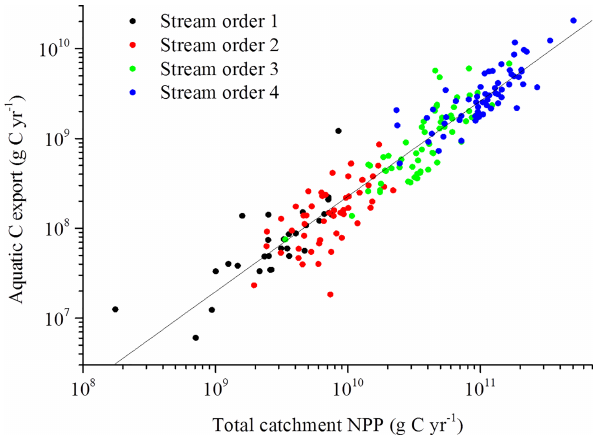
Figure 3. Annual rate of C export through the stream network ver- sus terrestrial NPP in the catchment area. Different colors indicate sampling sites from different stream orders. The solid line shows the fitted linear regression model for the log-transformed data with C_export=0.005 · NPP 1 . 06 ( r 2 = 0 . 89, p< 0 . 001).